Question: Name the type of graph shown.
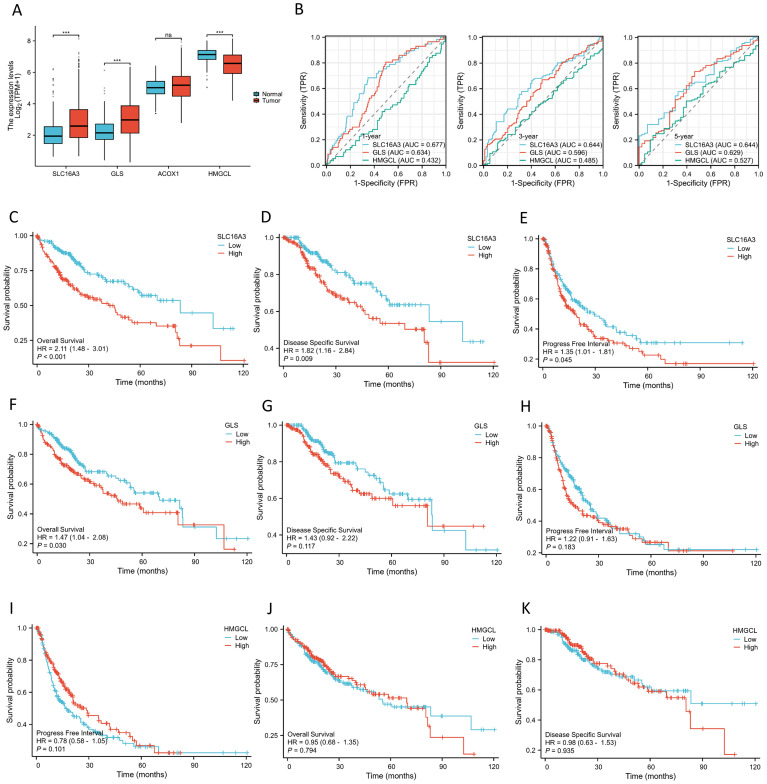
Answer: survival